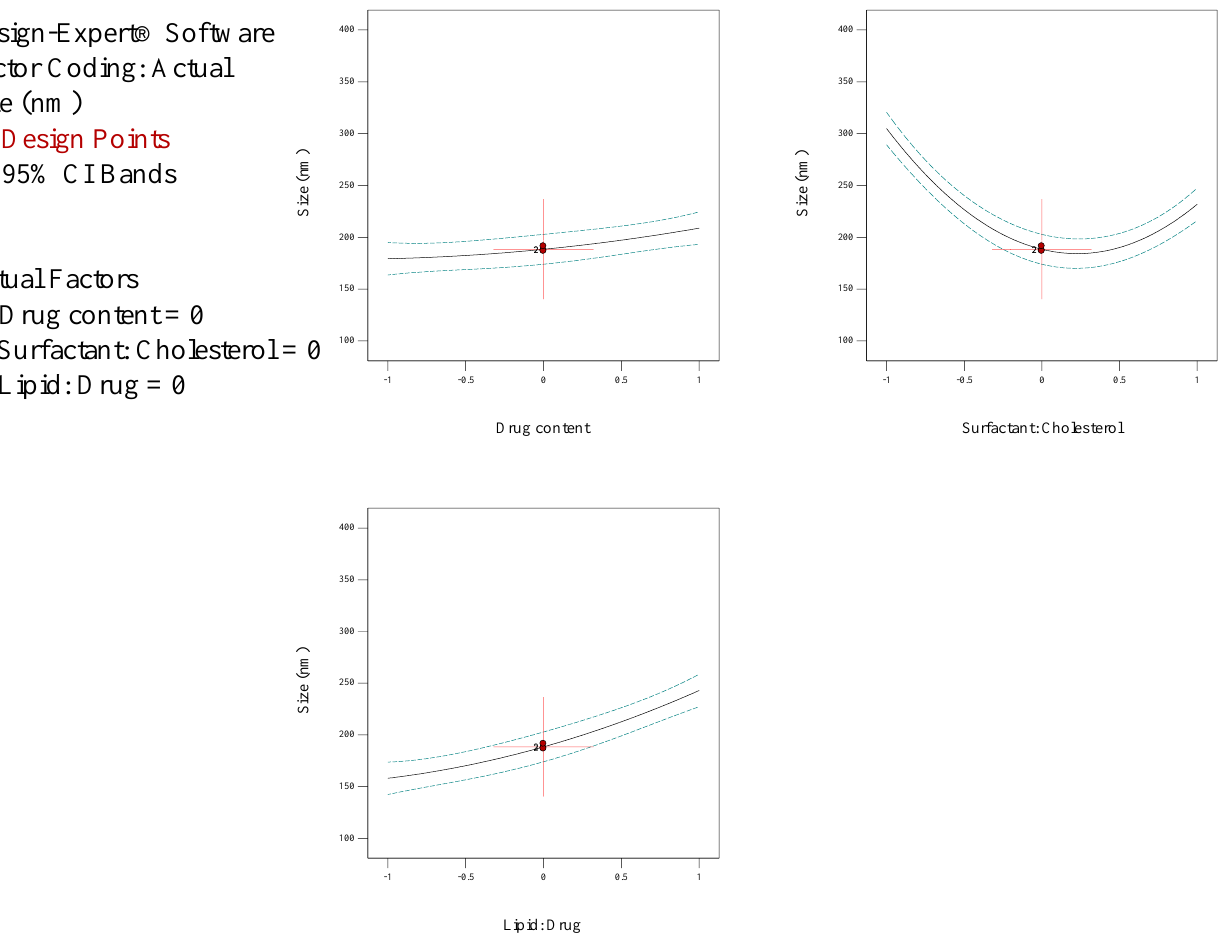
Figure 3. Box–Behnken method for average diameter as a mission of the drug content, the molar coefficient of surfactant: cholesterol, and molar ratio of lipid: drug .